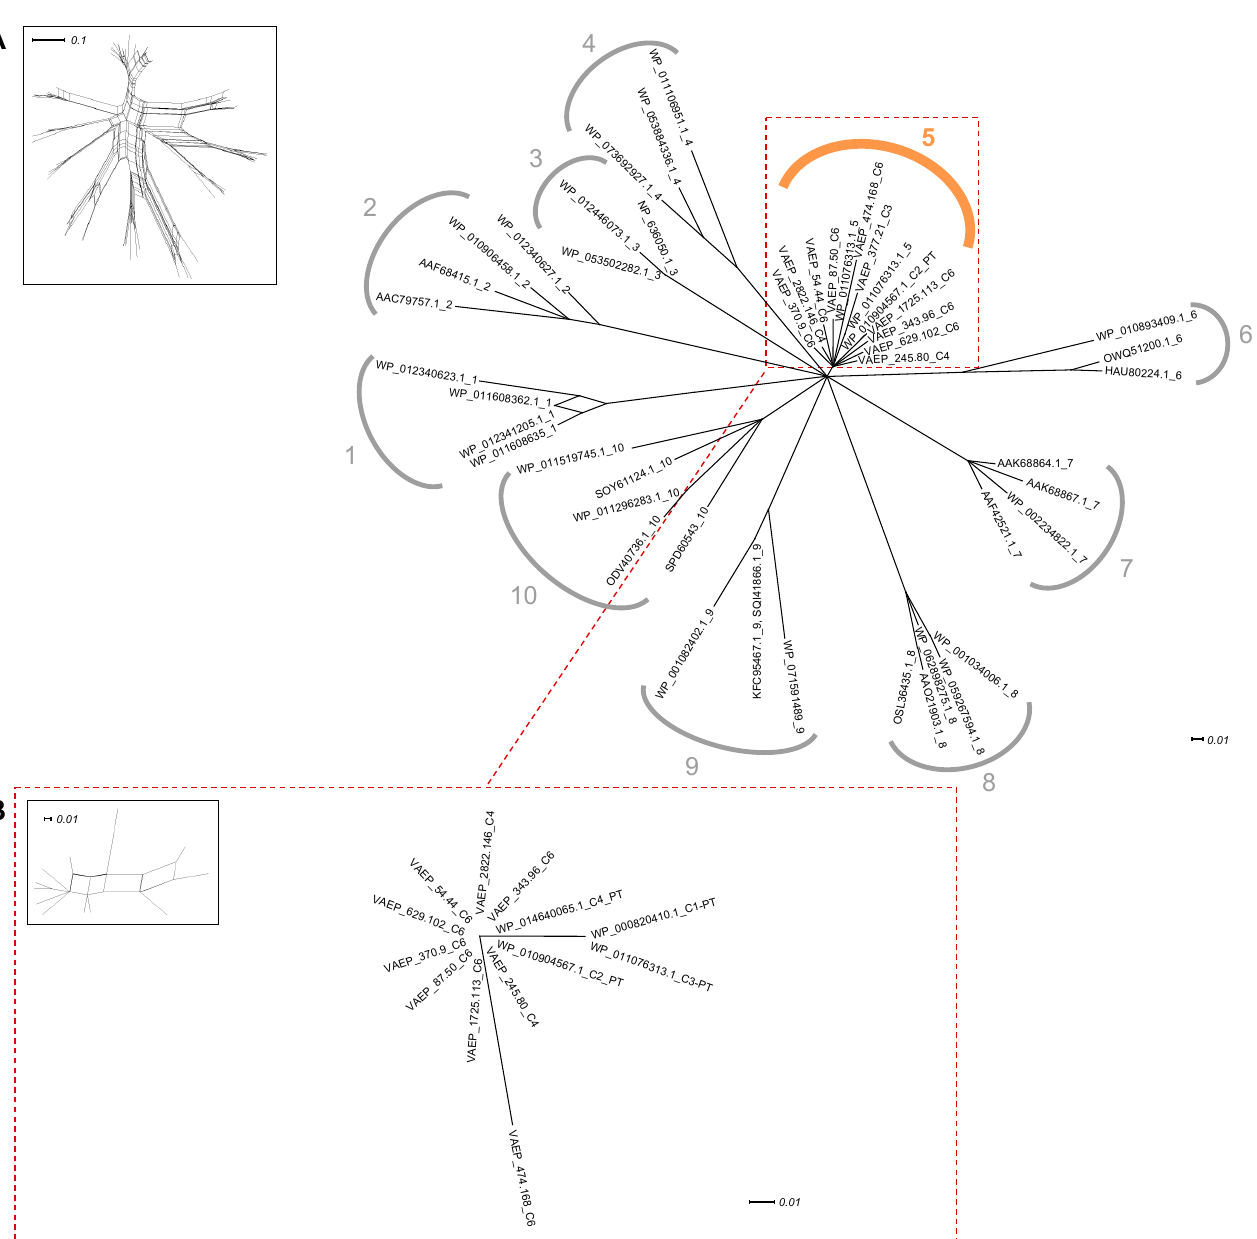
Figure 5. Phylogenetic analysis of the ESPR in Ag43. Trees were generated using SplitsTree; inserts represent the trees before applying bootstrapping and confidence threshold. ( A ) ESPR from Ag43 respective to the ten different AT ESPR clusters (numbered from 1 to 10) as previously reported, [24,33]. ( B ) Phylogenetic analyses of the EPSR from Ag43 only. For legibility, sequences that were identified but have not been included here are available in Table S1. Scale bars represent the evolu- tionary distance.